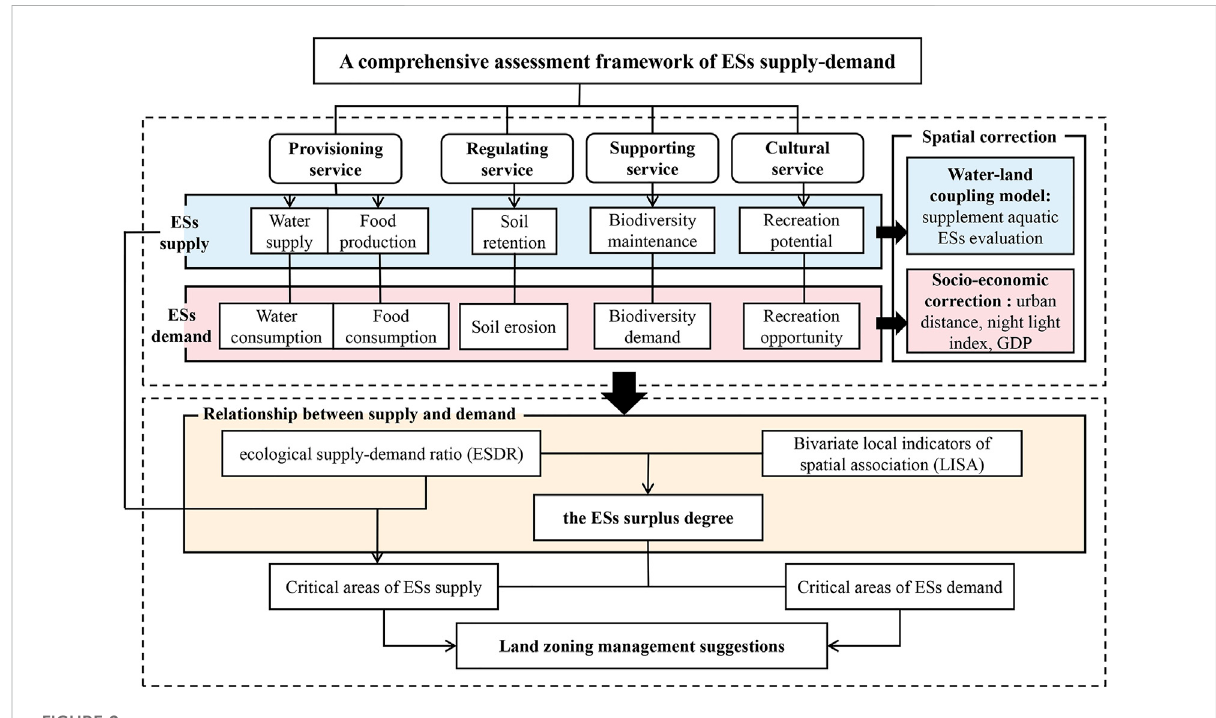
FIGURE 2 Research framework for assessing ES supply –